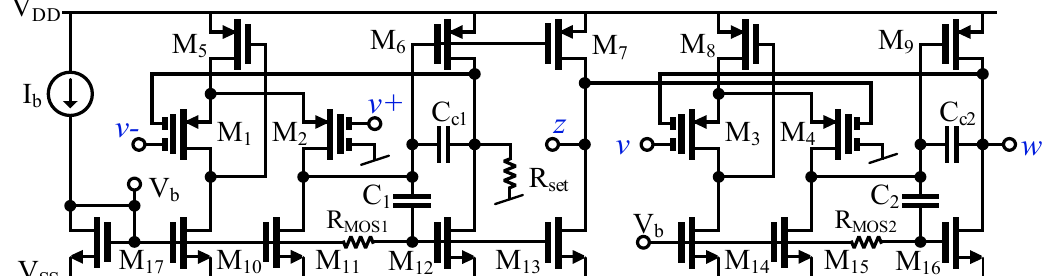
Figure 4. The CMOS structure of the VD-DIBA.